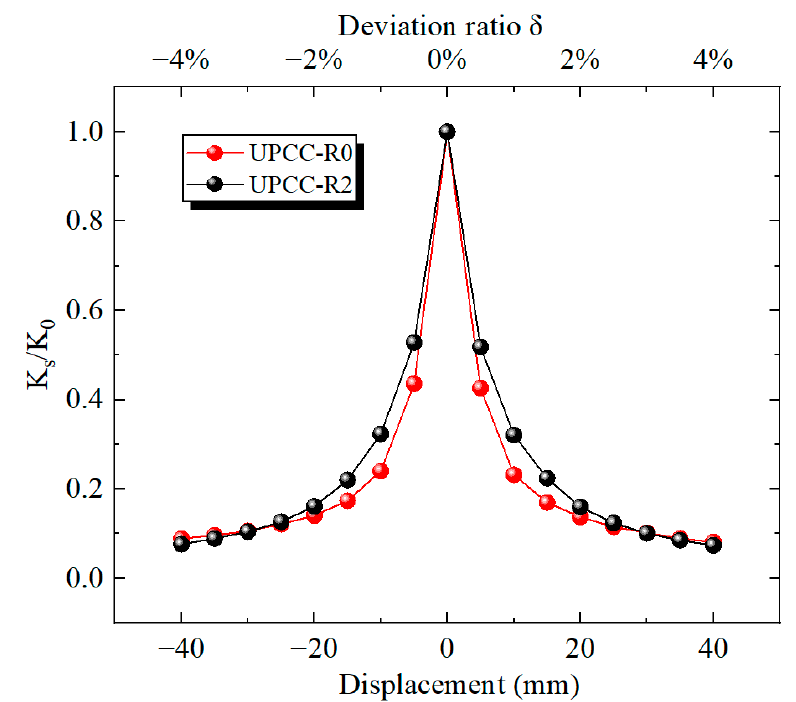
Figure 15. Stiffness degradation curves of two types of bridge piers.